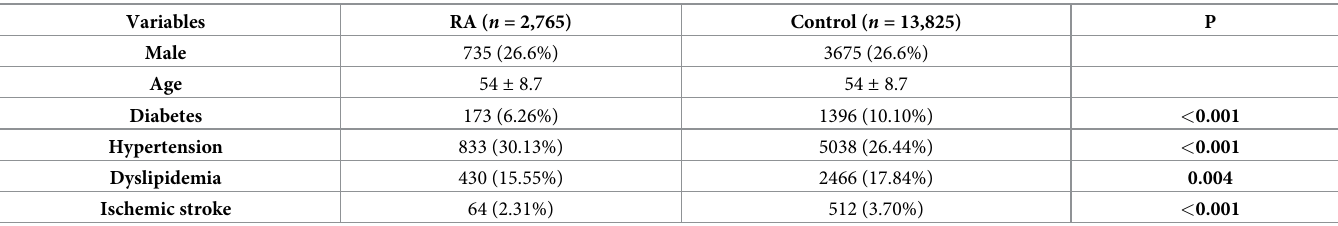
Table 4. Characteristics in the seropositive RA and control groups.